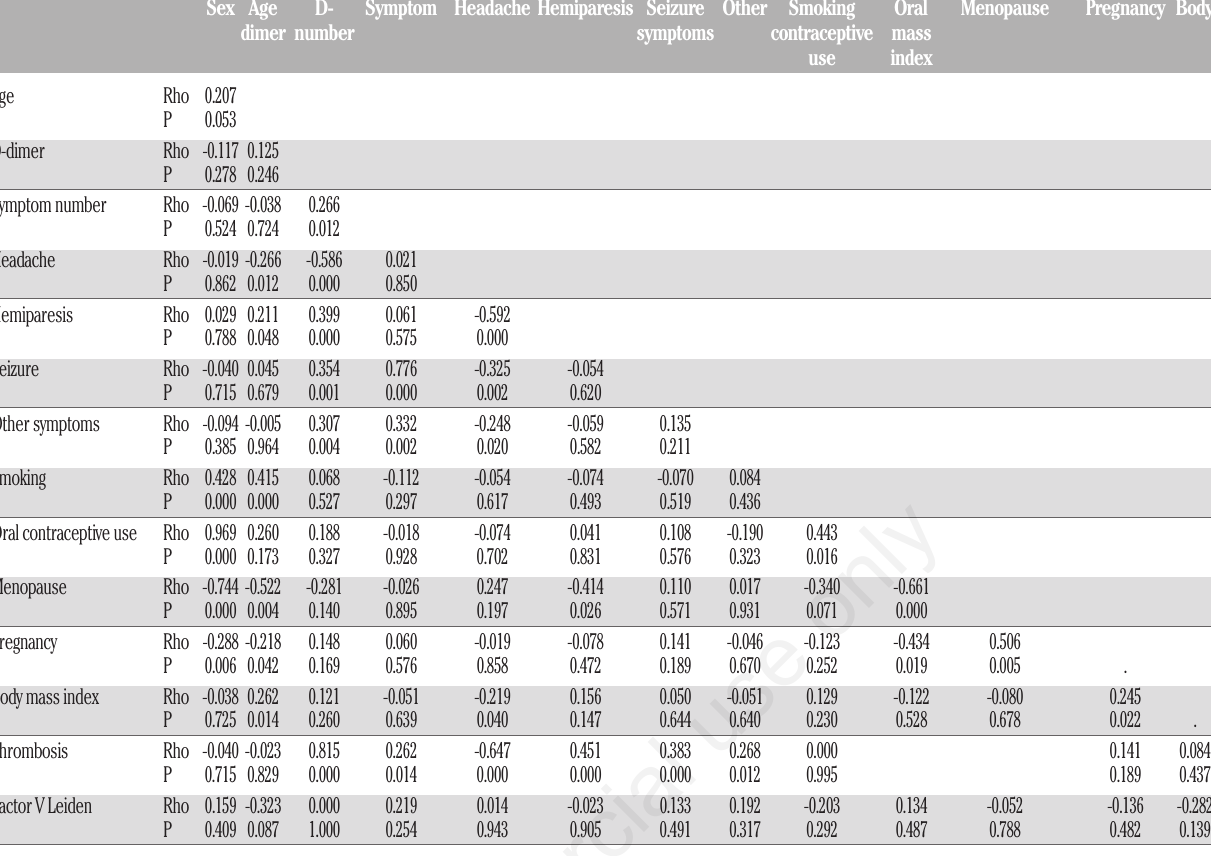
Table 2. Spearman correlation coefficient test of D-dimer serum level in patients with and without cerebral venous thrombosis. Sex Age